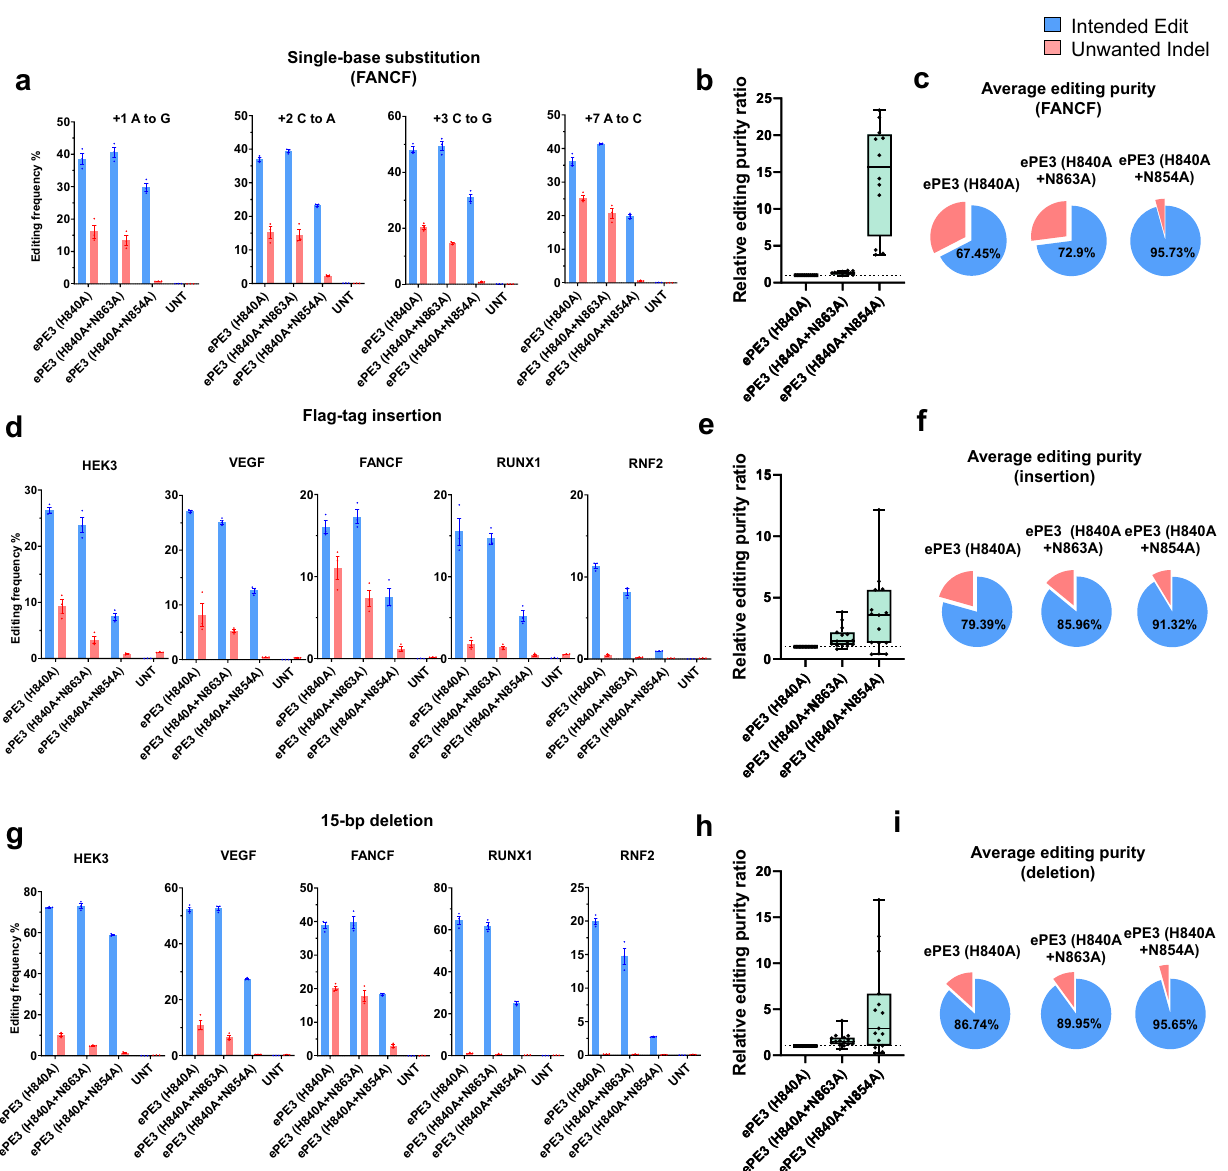
were transfected into HEK293T cells. Relative editing purity ratios normalized to the ePE3 (H840A) activity for insertions ( e ) and deletions ( h ). The average editing purities associated with the PE (nCas9 variants) for correct insertions ( f ) and deletions ( i ) shown in pie charts. Blue: intended edits; red: unwanted indels. Average editing purity: the number of reads containing the correct edit / the total number of reads containing edits (correct edits + unwanted edits)*100. Mean± SEM ( a , d , g ) were determined three independent experiments. Mean±SEM ( b , e , h )ofallindividualvaluesofsetsof n =3independentreplicatesareshown.For the boxes( b , e , h ),the top,middle, and bottom lines represent the 25th, 50th, and 75thpercentiles,respectively.Thewhiskersindicatemintomaxvalues.Sourcedata are provided as a Source Data fi